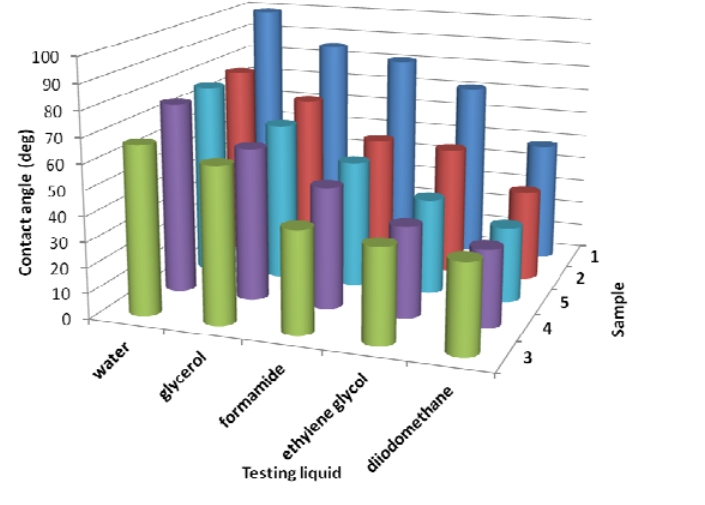
Figure 2. Contact angle vs. surface treatment and vs. testing liquid; 1 - untreated LDPE; 2 - plasma-treated; 3 - AA grafted; 4 - triclosan coated; 5 - chlorhexidine